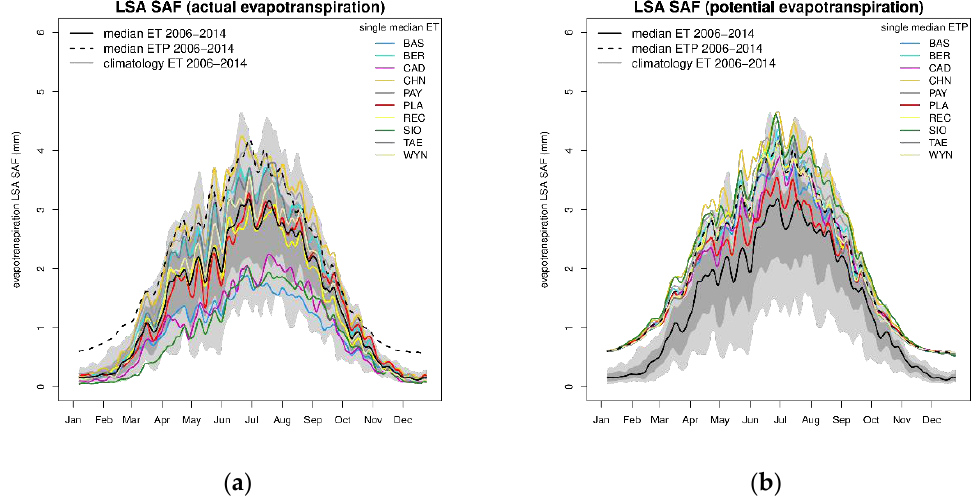
Figure 7. Seasonal evolution of daily evapotranspiration from spatially-aggregated satellite-based data from 2006 to 2014 (based on the grid cells closest to the ten considered grassland stations). The dark grey shading shows the 25–75% range; the light grey shading shows the 5–95% range. The median of the respective time series as well as the evolution of the ( a ) single actual evapotranspira- tion (ET) median and ( b ) the single potential evapotranspiration (ETP) median for each station is